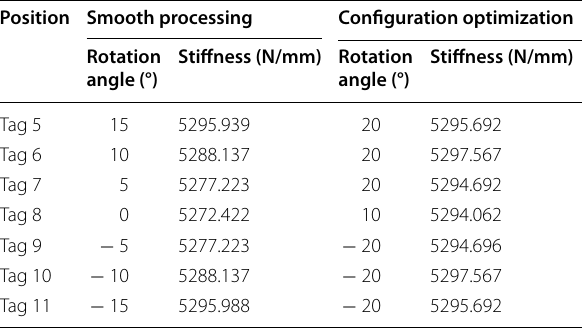
Table 1 Stiffness performance comparison between smoothing processing and configuration optimization Position Smooth processing Configuration optimization